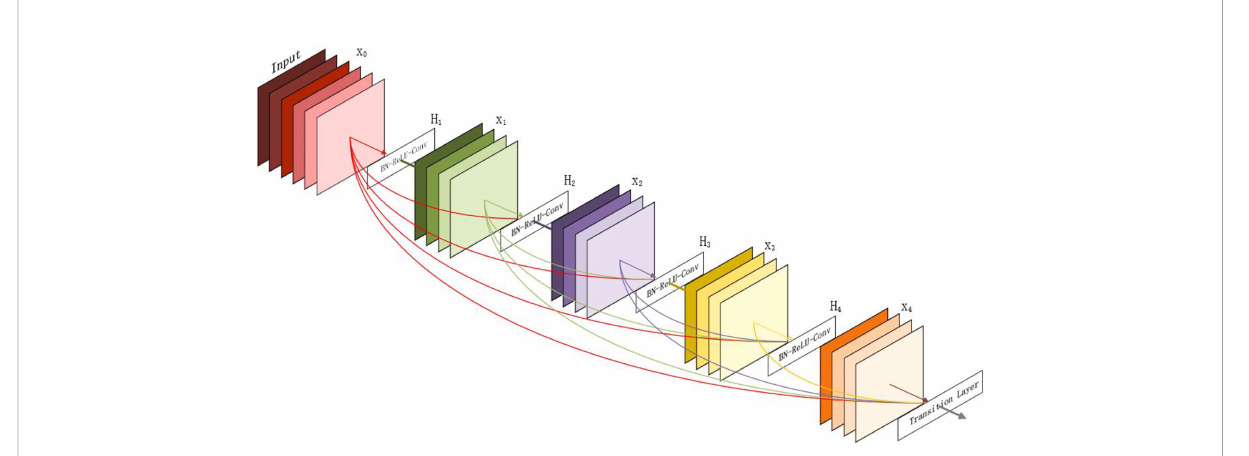
FIGURE 8 The DenseNet model diagram.